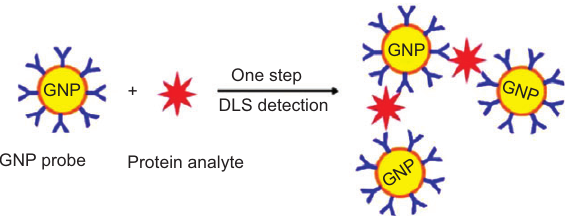
Figure 13 Illustration of a one-step homogeneous biomolecular assay using AuNP probes as lightscattering enhancers coupled with dynamic light-scattering detection. From Ref. [112]